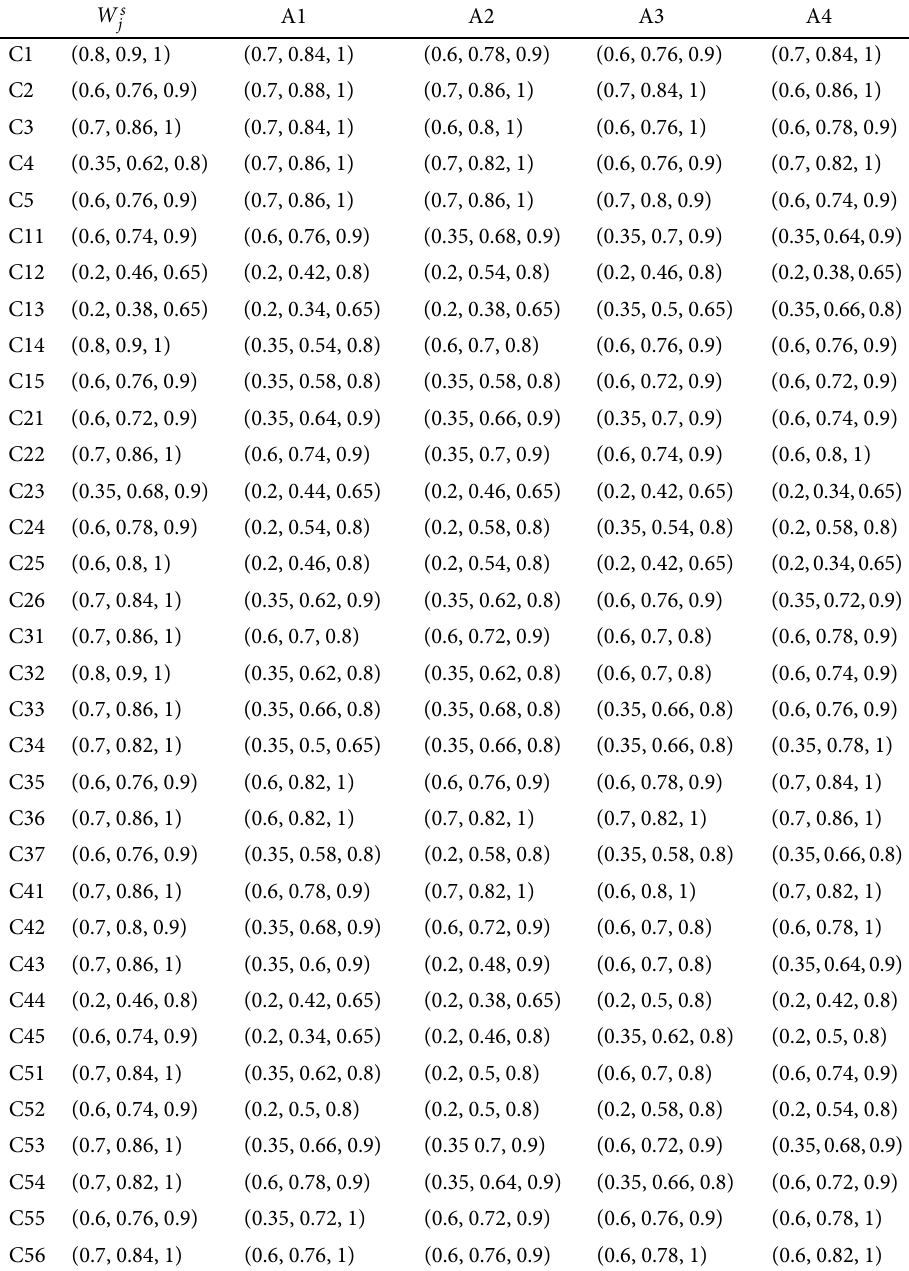
Table 3. Aggregated fuzzy values of alternatives rates and subjective importance